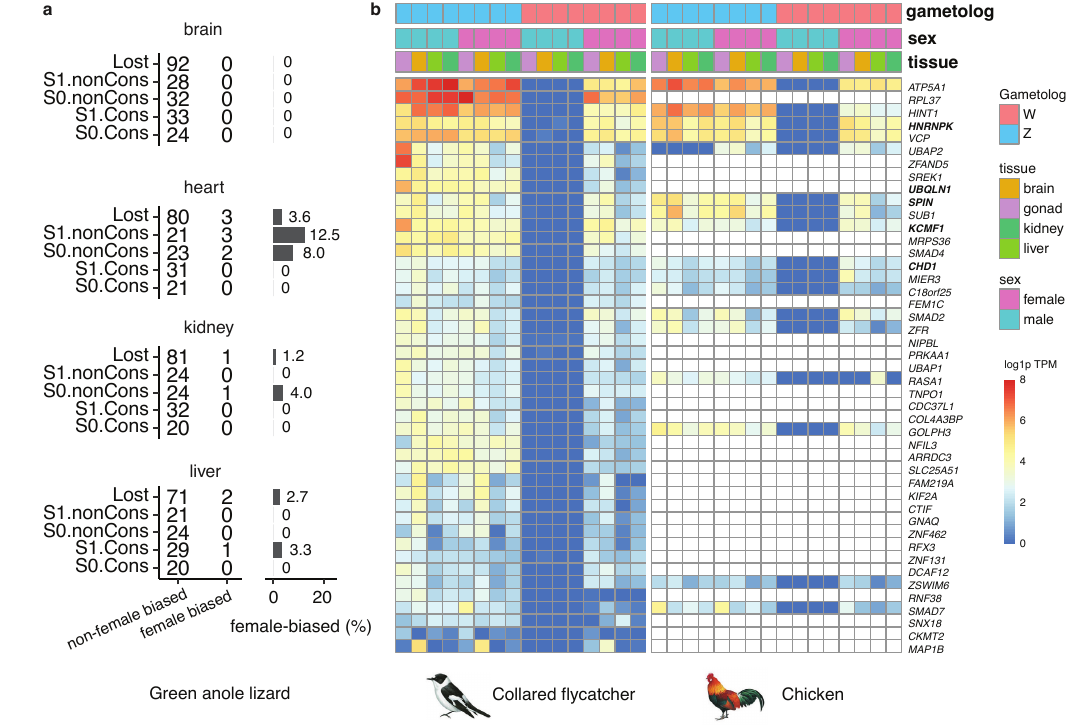
Figure 4. There is little evidence of feminization on the avian W chromosome. ( a ) The left panel shows the numbers of female-biased and non-female-biased genes in four tissues of the green anole lizard. The right panel shows the ratio of female-biased genes for each gene category. ( b ) The expression levels of genes that are present on the W chromosomes of collared flycatcher and chicken. Each row represents the expression level of both and Z- and W-linked gametologs in male and female tissues. The expression profile of W-linked gametologs in females is similar to that of the homologous Z-linked gametolog. Five conserved boundary genes are shown in bold. Log1p(TPM) means log(1 + TPM